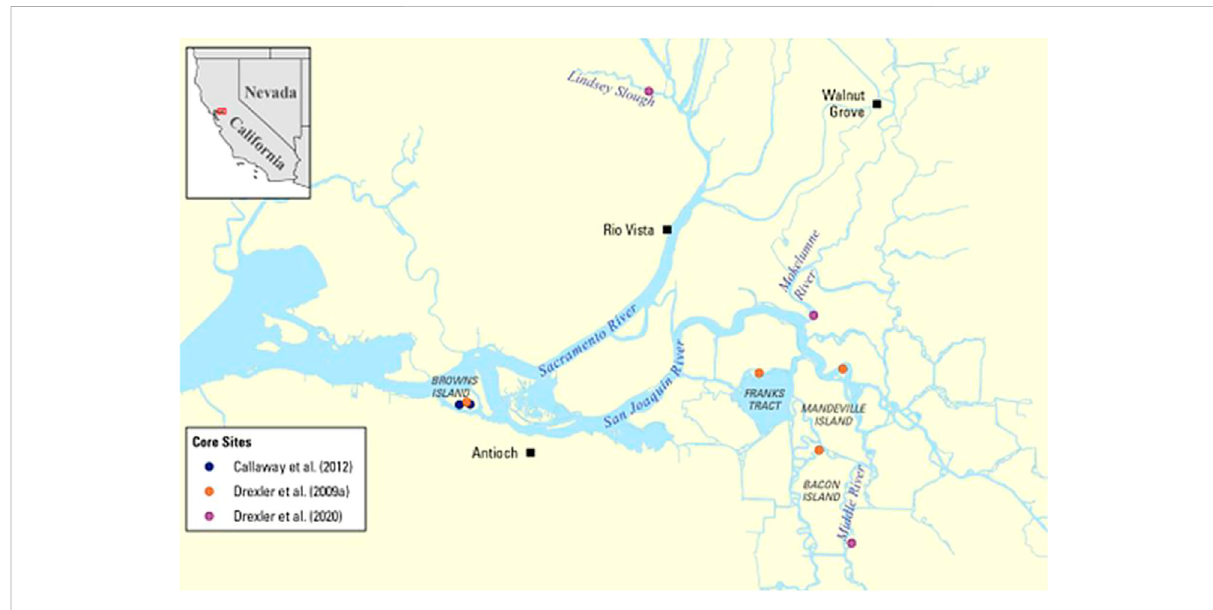
FIGURE 1 Location of the Sacramento-San Joaquin Delta in California and the peat cores that were collected across the